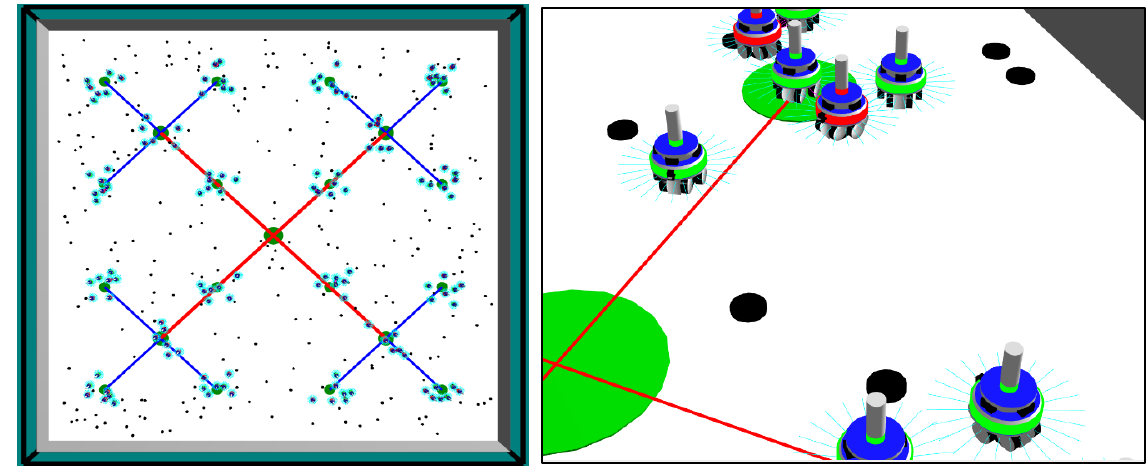
Figure 5. Screenshot of multi-place foraging in the ARGoS simulator : Bird-eye vs. Zoomed screenshot .